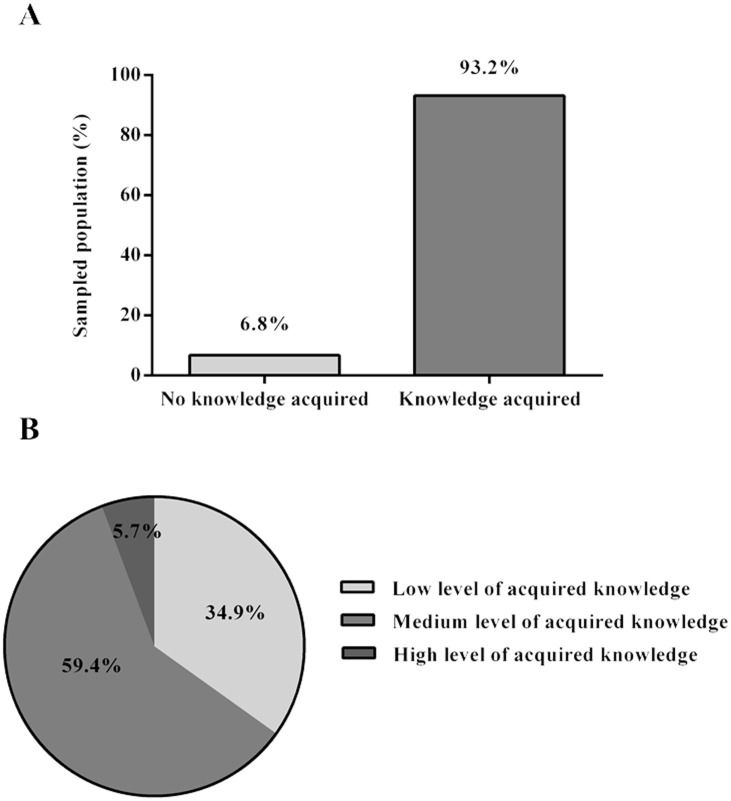
Knowledge Score.(A) Percentage of the population that acquired and that did not acquire knowledge after contact with the materials—general knowledge score. Knowledge acquisition was measured using the final knowledge score (an index that uses a scale between zero and one—zero representing no knowledge acquisition and one representing maximum knowledge acquisition). (B) Levels of acquired knowledge (%): low level of acquired knowledge, medium level of acquired knowledge, and high level of acquired knowledge; these levels were defined according to the final knowledge score of the total population. The graphs represent the data for all groups of the population sample.